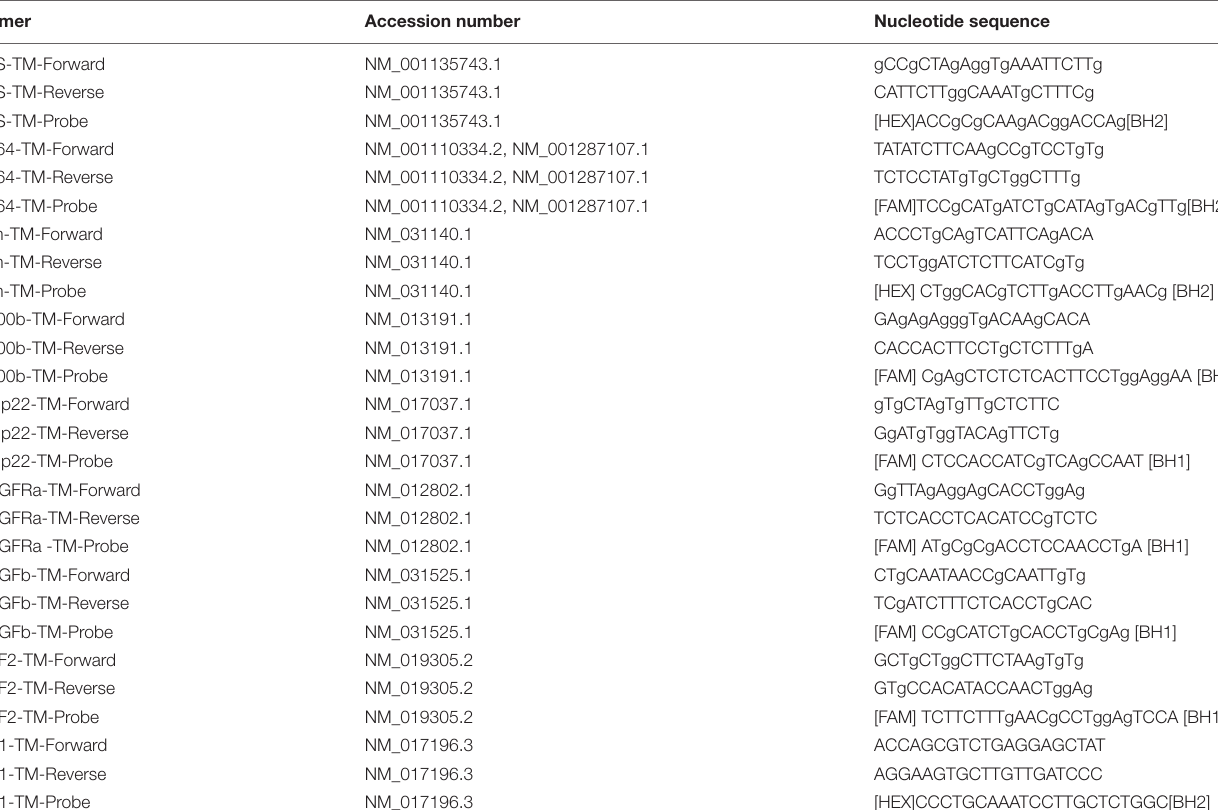
TABLE 3 | Primers and probes for